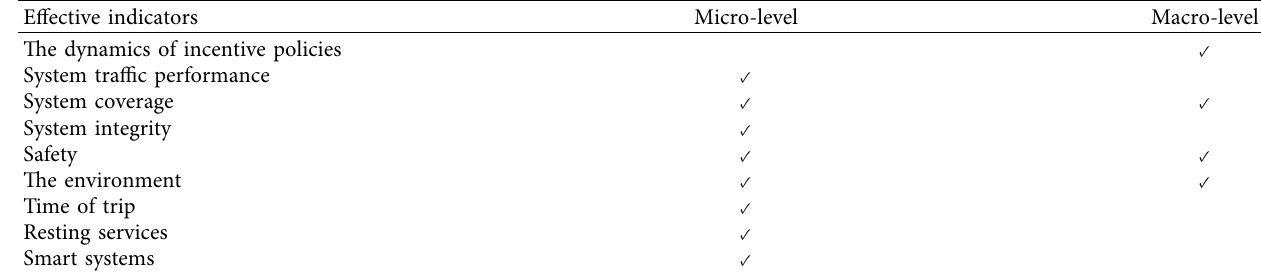
Table 3: Indicators affecting the utility of the public rural road transport system.